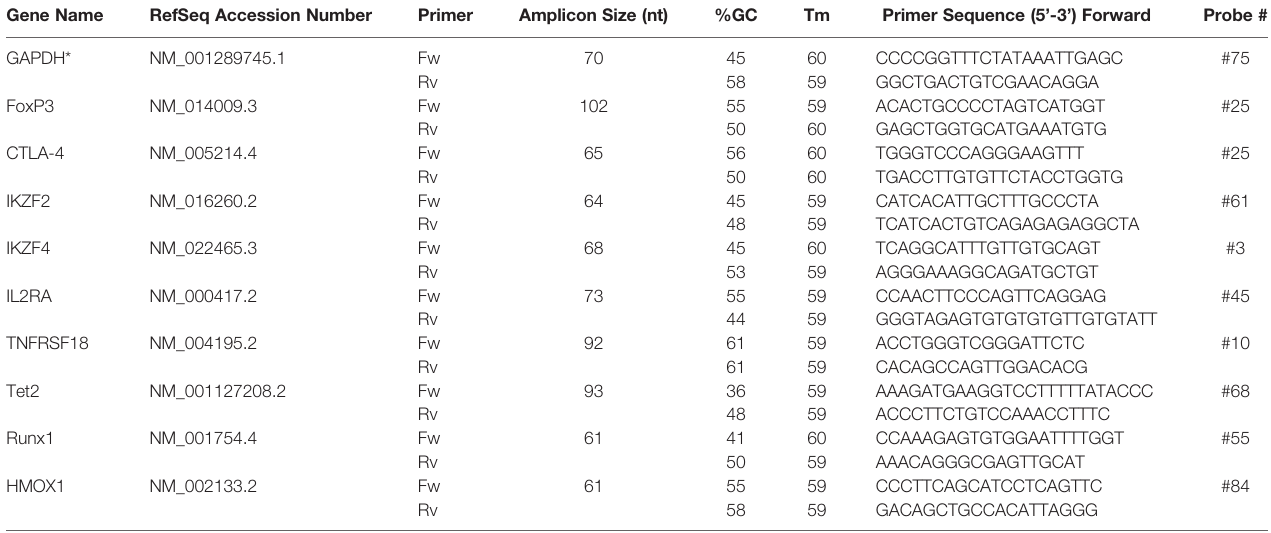
TABLE 1 | Sequences of primers used for real-time